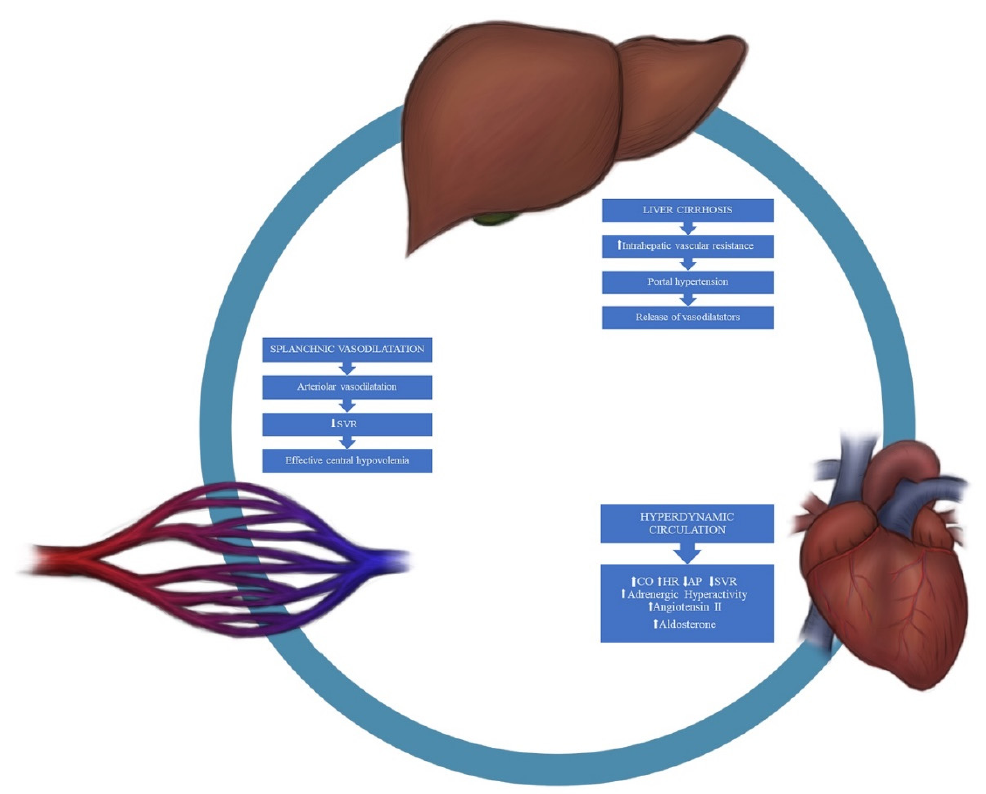
Figure 1. Patomechanism of CCM. SVR—systemic vascular resistance; CO—cardiac output; HR—heart rate; AP—arterial pressure.